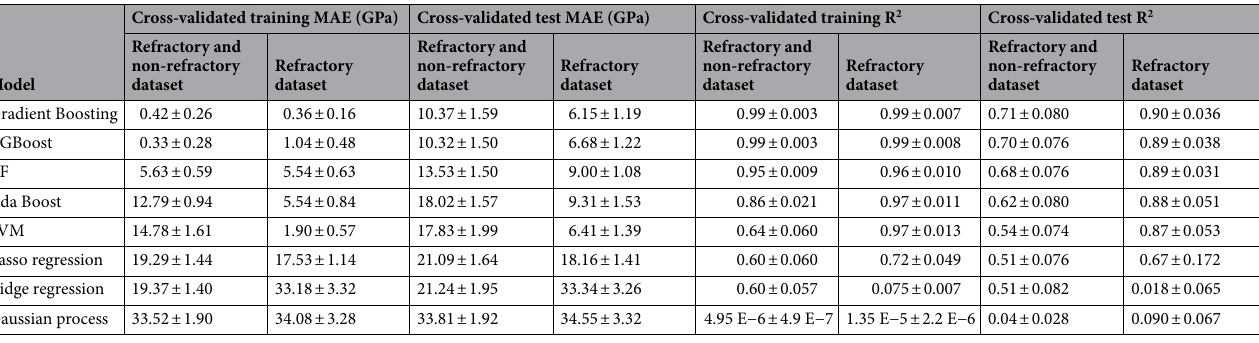
Table 2. Optimized hyperparameter and cross-validated MAE and R 2 for both data sets.